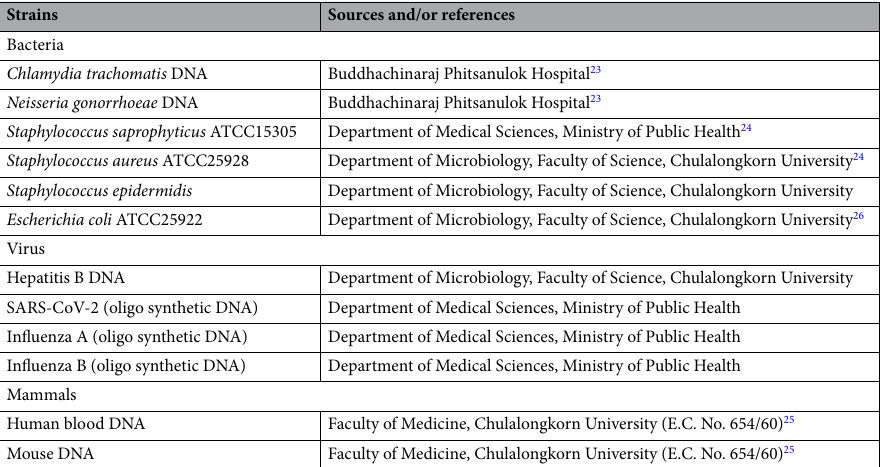
Table 2. List of bacteria, virus, and mammal strains used as negative samples in specificity test. Strain number (e.g., ATCC15305) is not available for some samples, because DNA was isolated and sequencing identification was performed from local